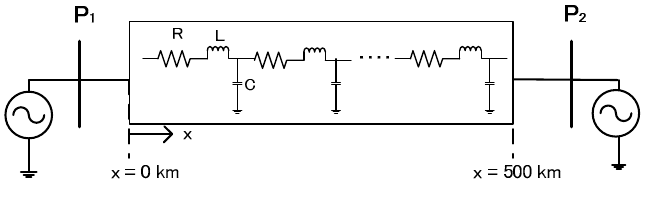
Figure 15. Cable model for the simulation.